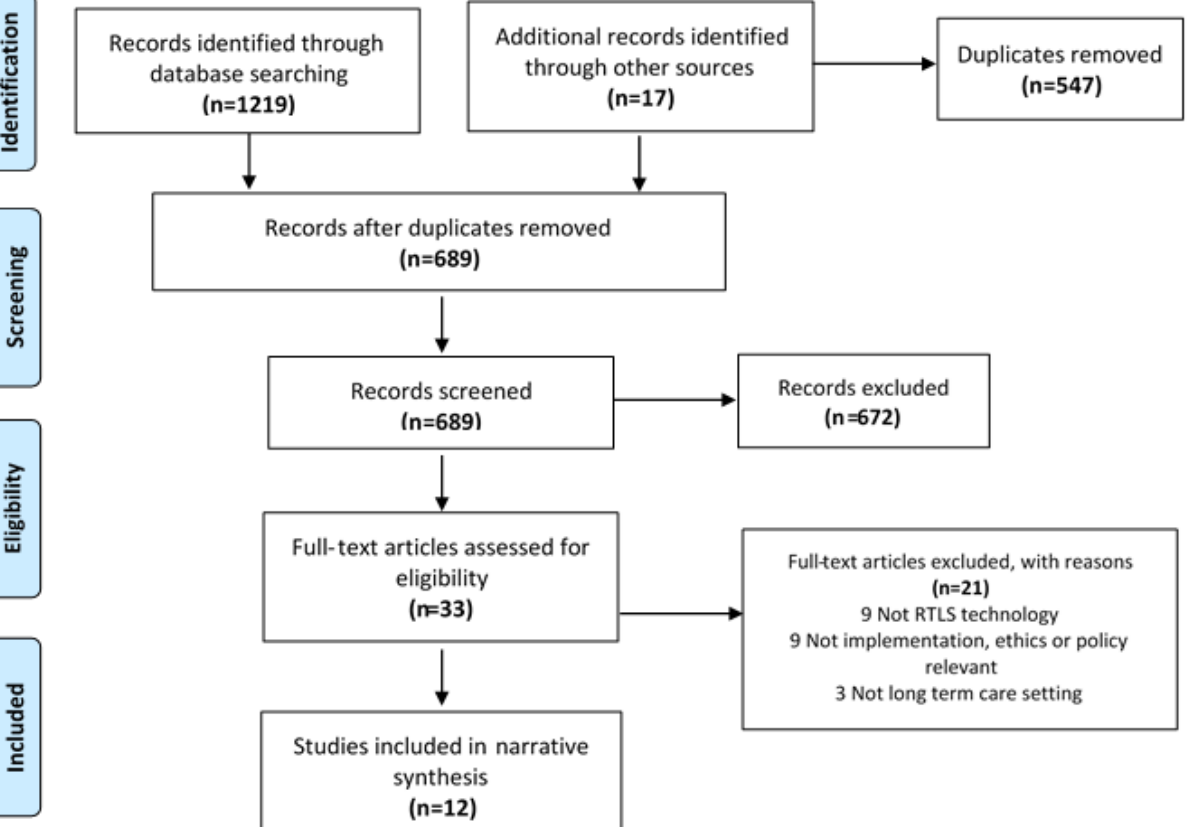
Figure 1. PRISMA (Preferred Reporting Items for Systematic Reviews and Meta-Analyses) flow diagram. RTLS: real-time locating